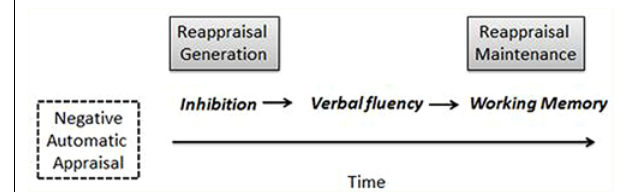
new positive, or less negative, meanings are generated. On the second stage ( reappraisal maintenance ) positive, or less negative, new meanings are kept in mind and protected from competing negative appraisals. Inhibition and verbal fluency are key abilities for reappraisal generation, while working memory is central for reappraisal